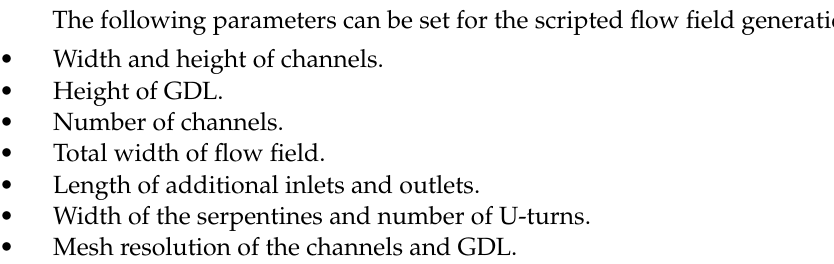
Figure 7. Example of the channel configurations generated by the toolbox. ( a ) Straight channel; ( b ) parallel serpentine; and ( c ) separate serpentine.